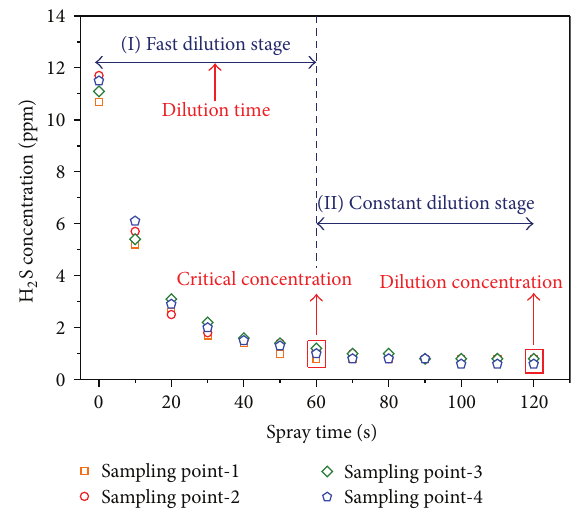
Figure 2: Illustration of the forced dispersion of H 2 S releases as a function of spray time in four sampling